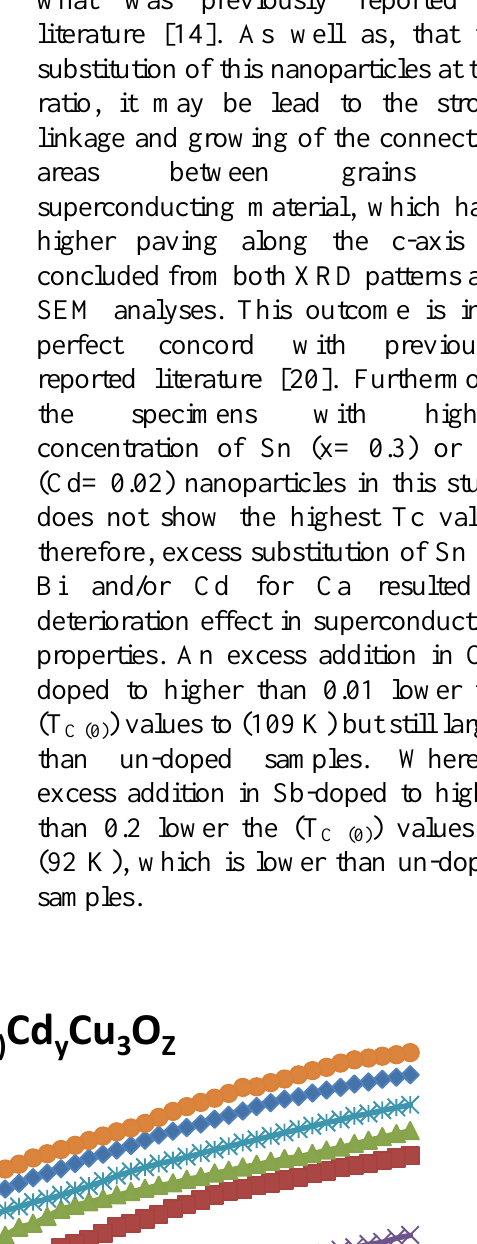
Fig.3: The (electrical resistivity – temperature) curves of Bi samples as a function of partial substitution of Sn with x = (0.0, 0.1, 0.2 and 0.3), and partial substitution of Cd with y = (0.00, 0.01 and